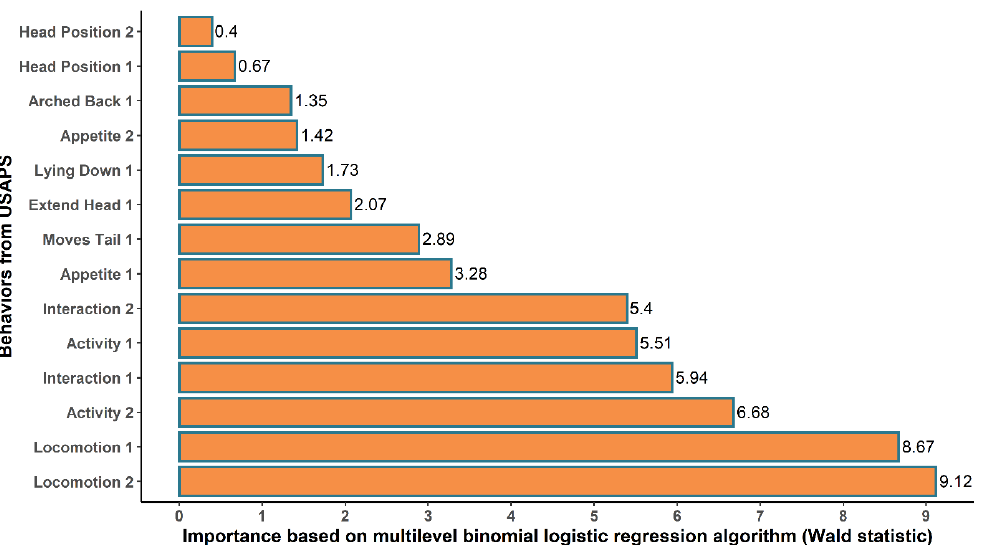
Figure 1. Importance of each behavior from USAPS based on the Wald statistic of the fixed effects in the multilevel binomial logistic regression algorithm using the expert opinion (no-event = no indication of analgesia; event = indication of analgesia) as the predictor variable.